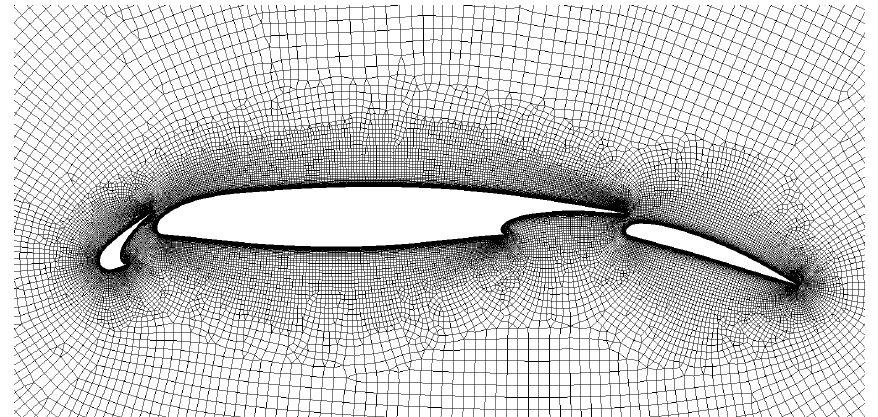
Figure 4. Coarsest considered mesh for the NHLP-90-L1T2 high-lift configuration.